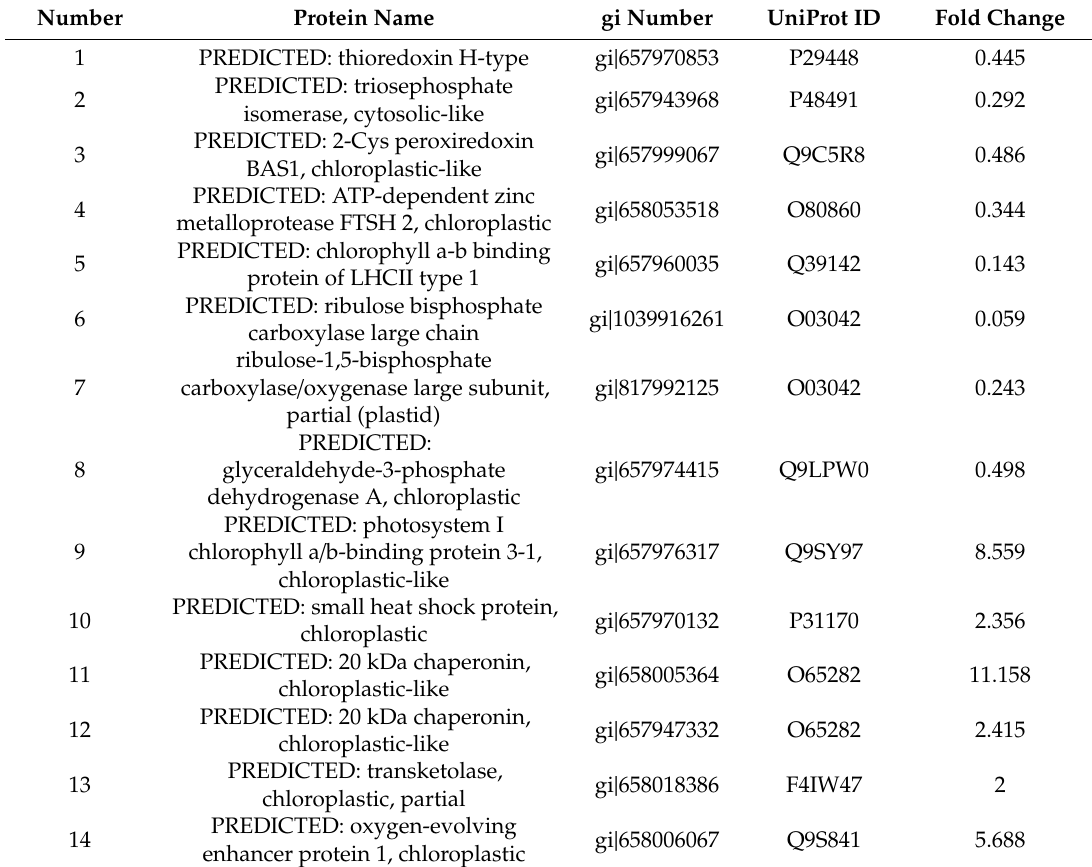
Table 1. Di ff erential expressed photosynthesis-related proteins in leaves of M . ‘Prairifire’ between CG and heat shock treatment for 48